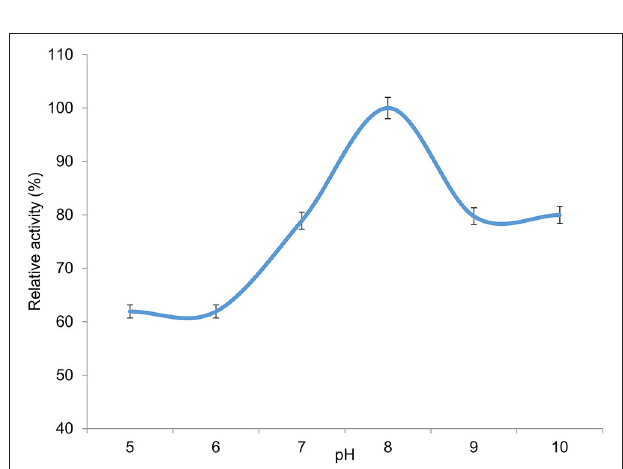
FIGURE 6 | Temperature dependency of the 7N9 esterase. The temperature dependency of the 7N9 esterase was tested at 4 ◦ , 20 ◦ , 25 ◦ , 30 ◦ , 37 ◦ , and 40 ◦ C. The values displayed are the means and standard deviations of triplicate measurements.